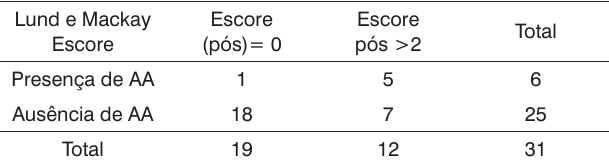
Tabela 5. Relação entre estadiamento tomográfico para